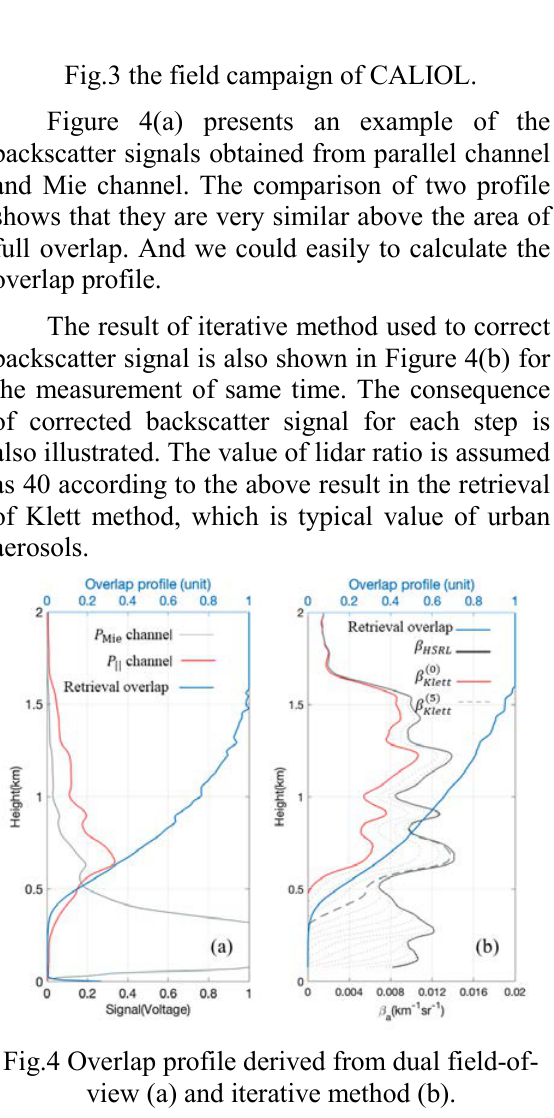
Fig.3 the field campaign of CALIOL.